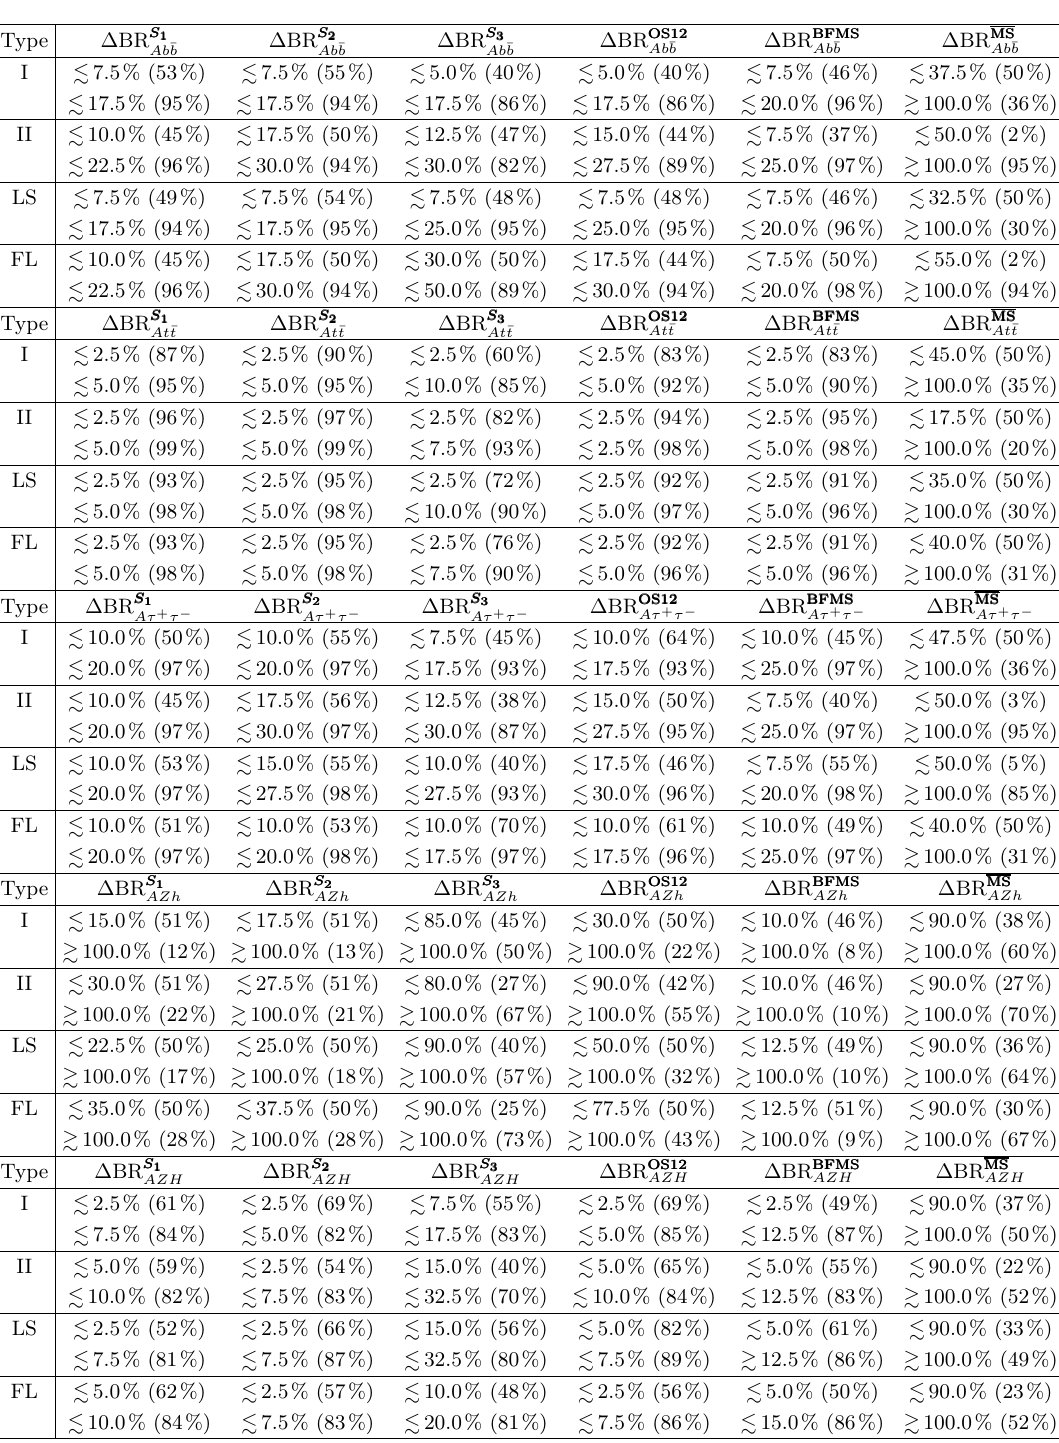
Table 13 . Relative size of the EW corrections to the BRs for the pseudoscalar 2HDM Higgs